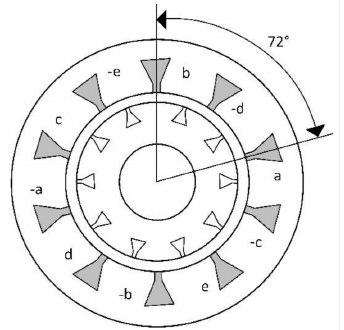
Figure 1. Winding distribution of a five-phase induction motor.